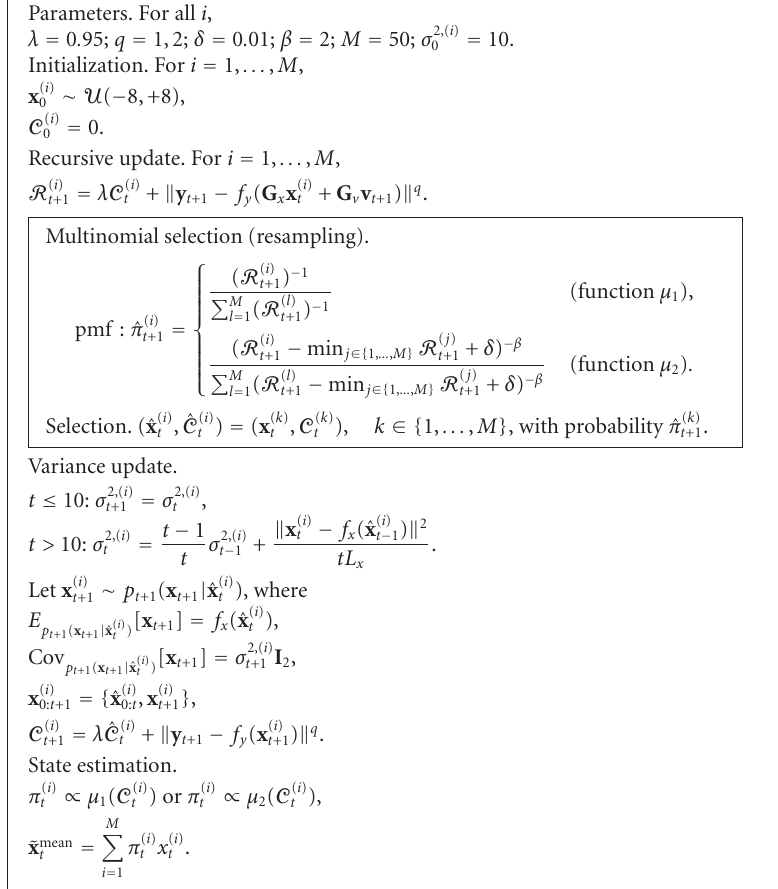
Algorithm 1: CRPF algorithm with multinomial resampling for the 2-dimensional positioning